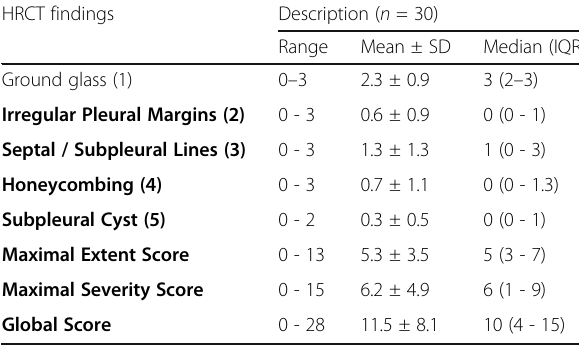
Table 5 Description of Score findings (range, mean, and